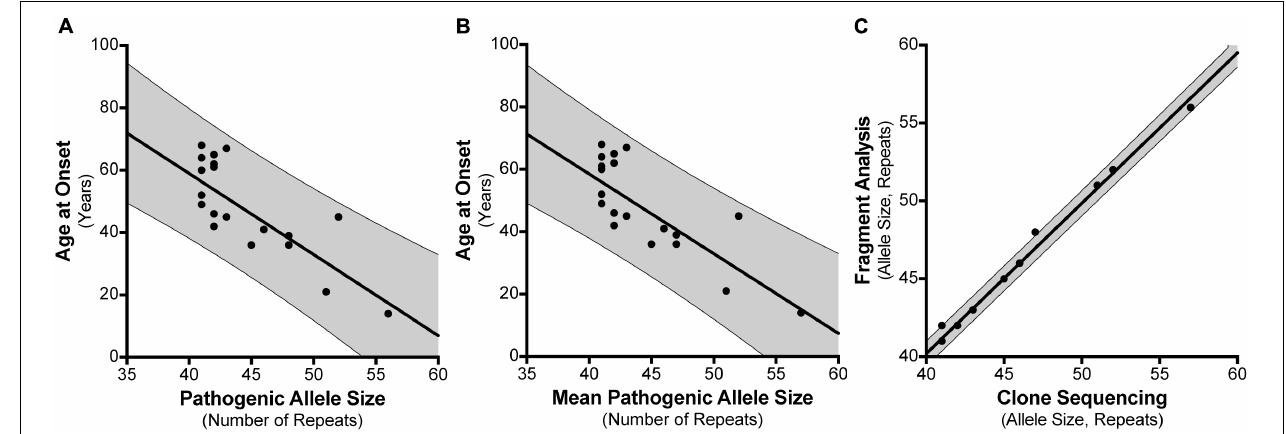
FIGURE 3 | Correlation between SCA17 pathogenic allele size and age at disease onset. Age at disease onset data was available for 21 SCA17 patients that had been both analyzed by fragment sizing and clone sequencing. Pathogenic allele size as determined by fragment sizing shows a negative correlation with respect to age at onset and a good fit to the linear model ( R 2 = 0.595) (A) . Cloning and sequencing the SCA17 alleles permits the calculation of the mean pathogenic allele size, rounded to the nearest whole repeat, based on the total length of the CAG/CAA repeat tract sequence. Mean pathogenic allele size as determined by clone sequencing also shows a negative correlation with respect to age at onset and an improved fit to the linear model ( R 2 = 0.6005) (B) . Comparing the SCA17 pathogenic allele sizes determined by these two methods there is a very significant correlation between the two and a high-quality fit to the linear model ( R 2 = 0.9935) (C) . The bold line depicts the linear model fit result and the 95% confidence interval bounds are shown by the narrow line and shaded in